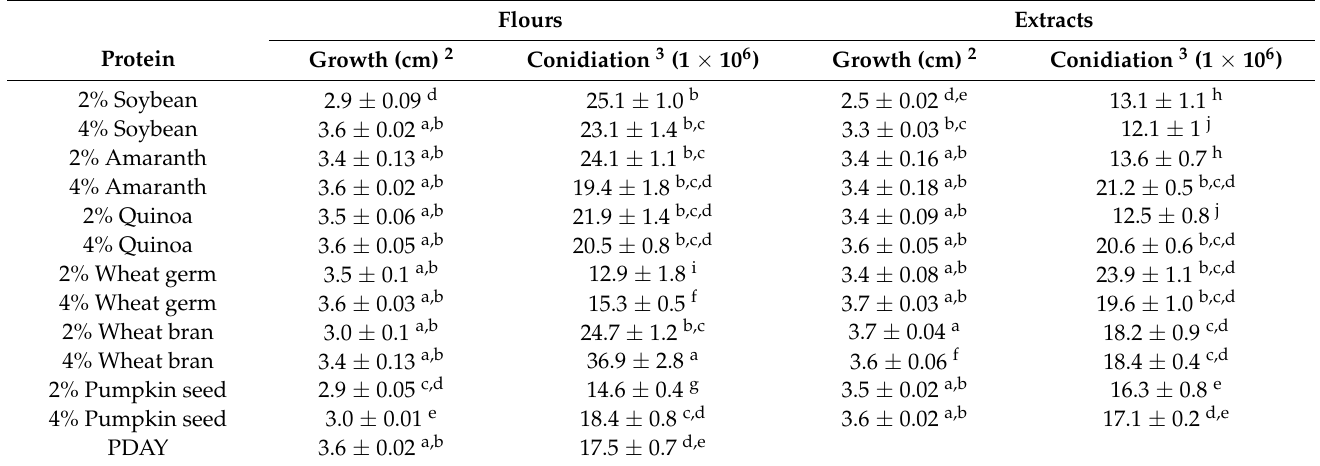
Table 1. Hirsutella citriformis strain INIFAP-Hir-2 radial growth and conidiation 1 . Flours Extracts